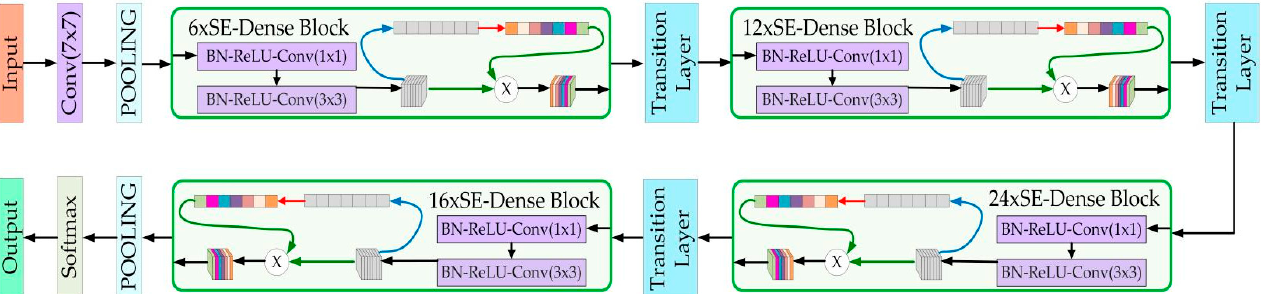
Figure 10. SE-DenseNet-121 pig cough sound recognition model.